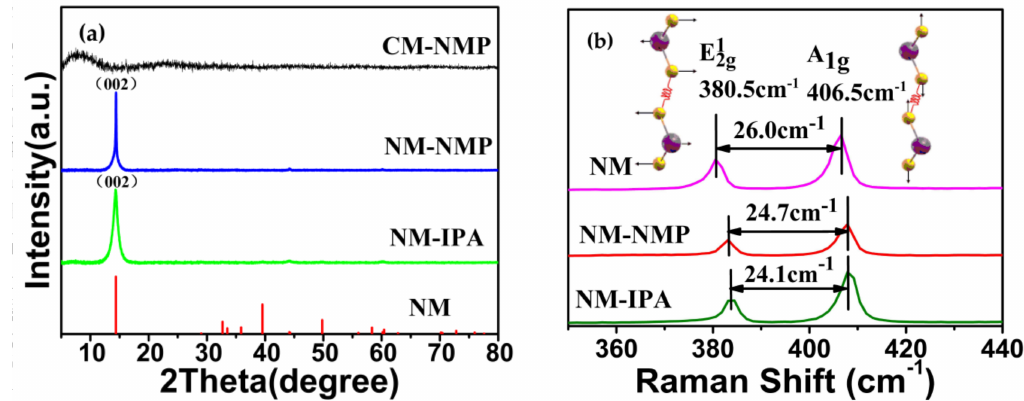
Figure 4. ( a ) X-ray diffraction (XRD) patterns of NM-NMP, NM-IPA, CM-NMP and bulk NM. ( b ) Raman spectra of bulk NM, NM-NMP and